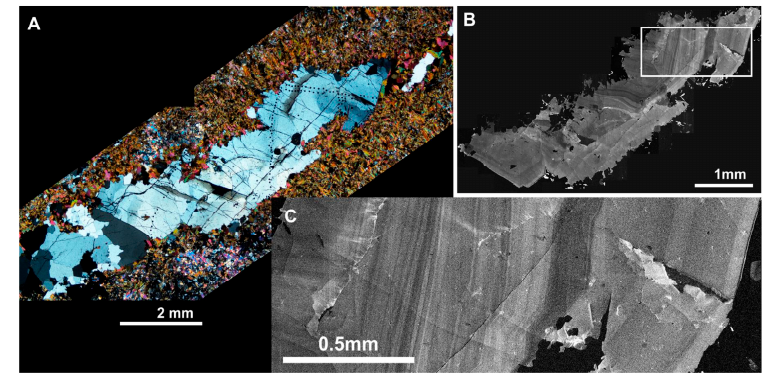
Figure 3. Optic and SEM image of stage I scheelite. ( A ) Polarized microscope image of stage I